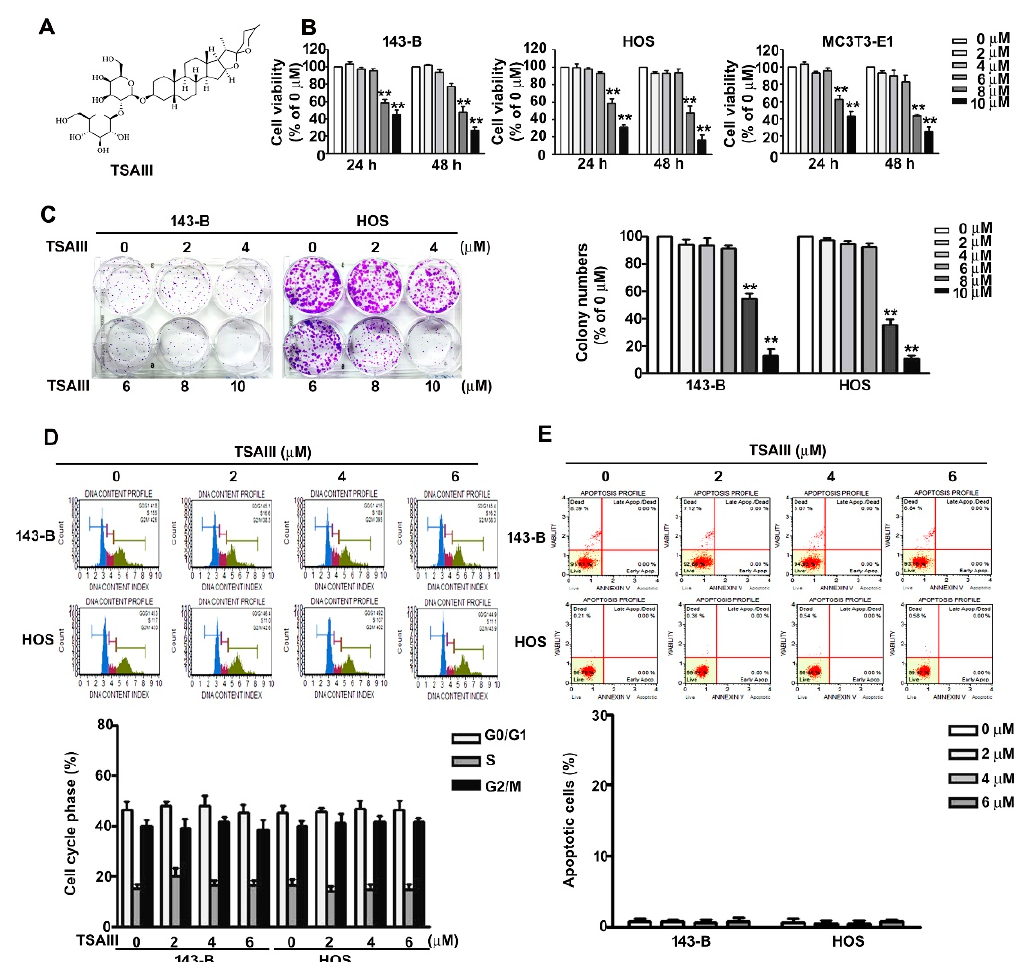
Figure 1. Effect of Timosaponin AIII (TSAIII) on viability and cytotoxicity of human osteosarcoma and normal osteoblast cells. ( A ) Structure of Timosaponin AIII (TSAIII). ( B ) 143-B and HOS cells (human osteosarcoma cells) and MC3T3-E1 cells (normal osteoblasts) were exposed to various concentrations (0, 2, 4, 6, 8, and 10 µ M) of TSAIII for 24 h, and cell viability was measured using the CCK8 assay. ( C ) Cell proliferation rate of human 143-B and HOS osteosarcoma cells exposed to TSAIII (0, 2, 4, 6, 8, and 10 µ M) for 24 h was measured using a colony formation assay. ( D ) Regulation of cell cycle distribution and ( E ) cell death in human 143-B and HOS osteosarcoma cells exposed to various concentrations (0, 2, 4, and 6 µ M) of TSAIII were analysed using Propidium Iodide (PI) staining or Annexin V/PI staining through flow cytometry. ** p < 0.01 versus control.